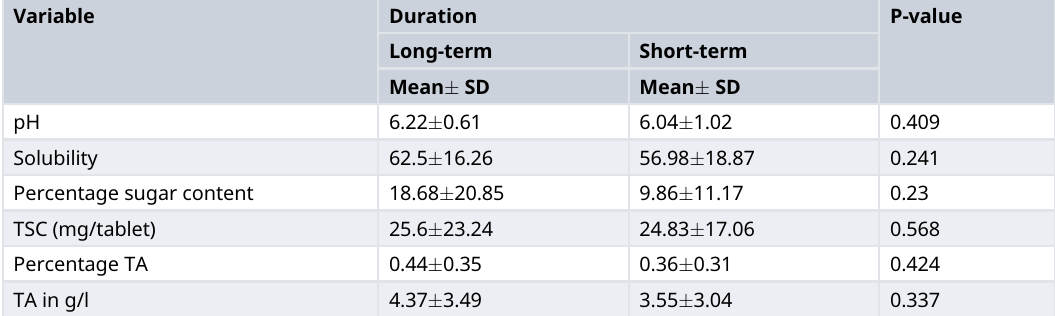
Table 4. Comparison of potential of hydrogen (pH), solubility, titratable acidity (TA), and total sugar content (TSC) between short and long-term ODTs.